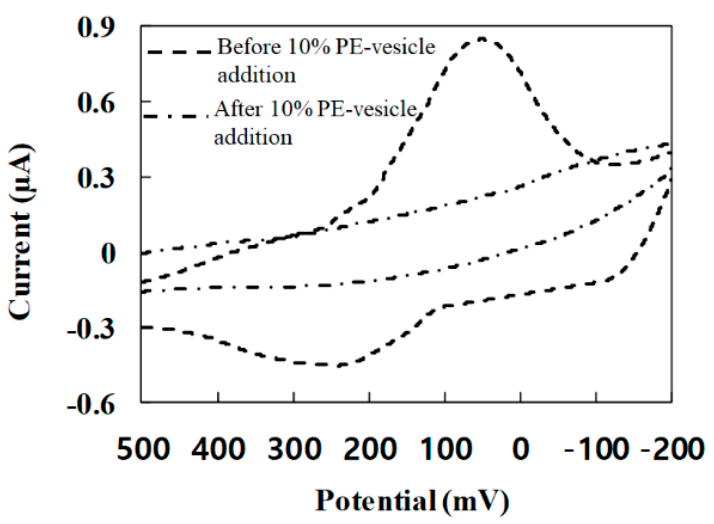
Figure 3. CV responses before and after the 10% PE-vesicle addition on the monolayer prepared with 90% MUD/10%